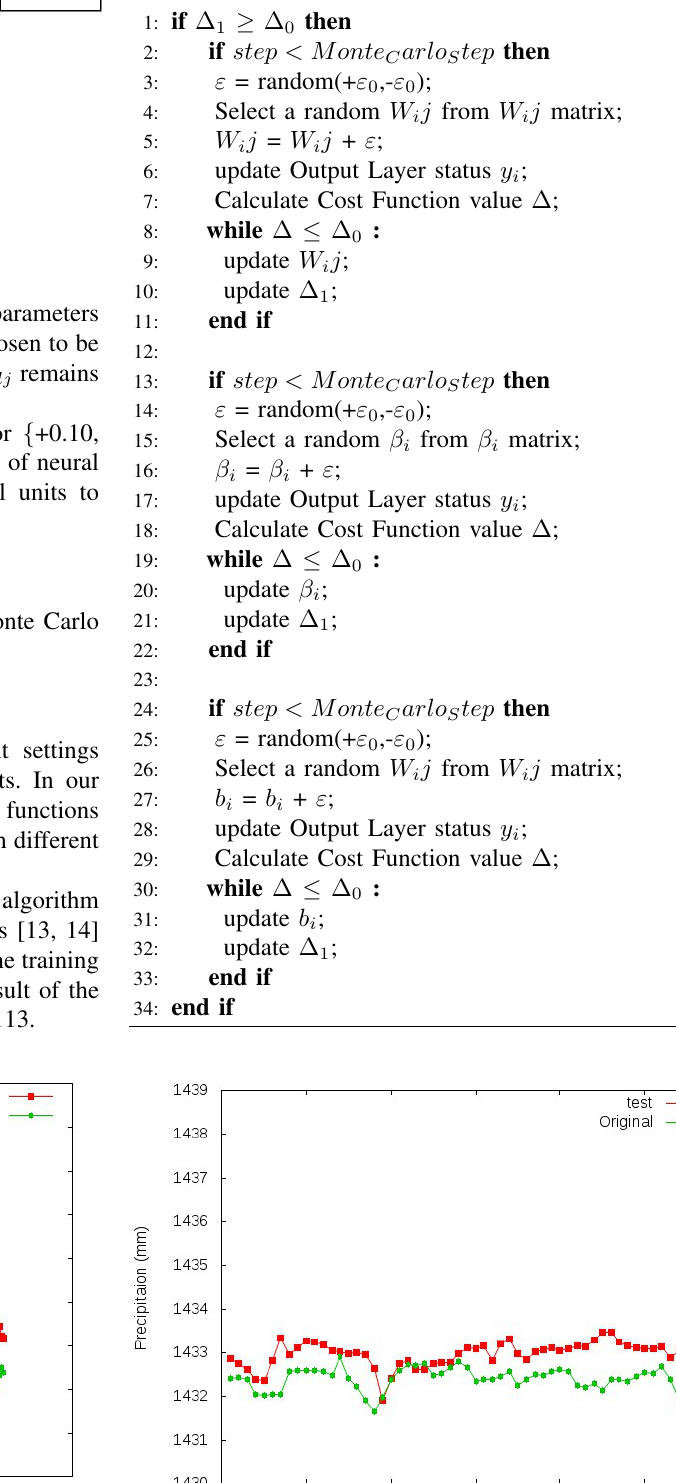
Algorithm 1 Monte Carlo algorithm